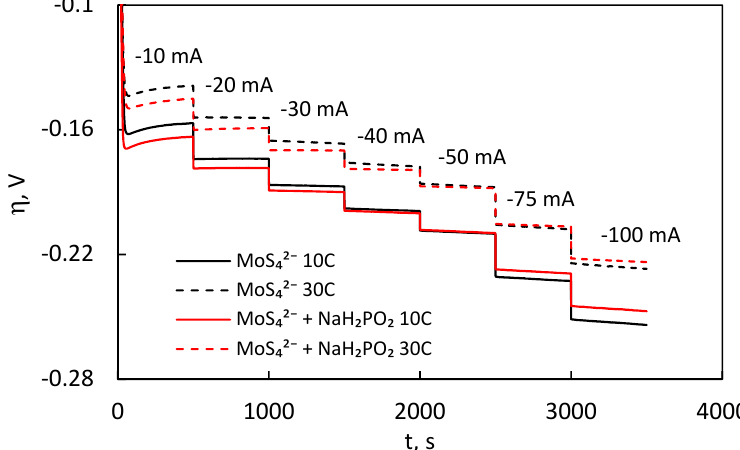
Figure 5. Galvanostatic stability curves of MoS 2 films, electrodeposited with and without NaH 2 PO 2 .